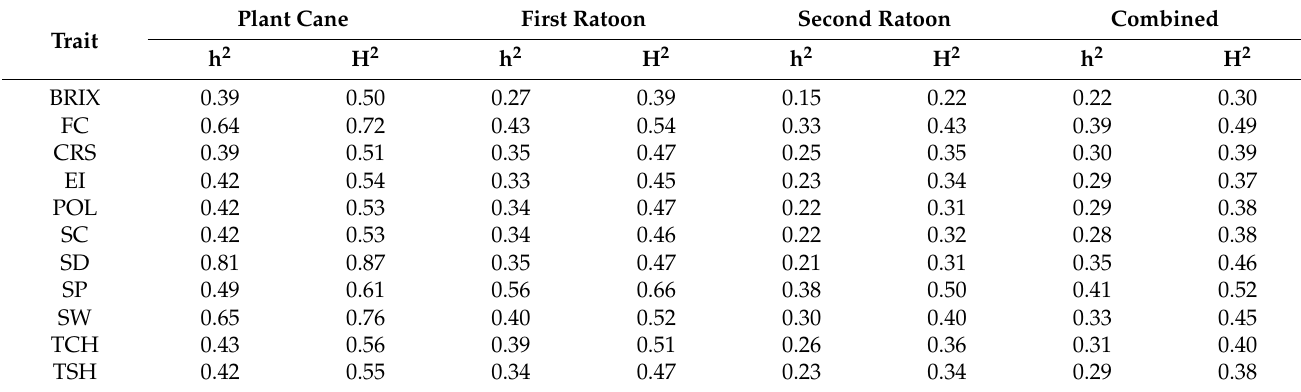
Table 1. Narrow-sense (h 2 ) and broad-sense (H 2 ) heritabilities of Brix, fiber content (FC), commercial recoverable sugar (CRS), economic index, pol, sucrose content (SC), stalk diameter (SD), stalk popula- tion (SP), stalk weight (SW), total cane per hectare (TCH), and total sugar per hectare (TSH) were estimated from the data generated in three crop cycles (plant cane, first ratoon, and second ratoon) and combined data of all three crop